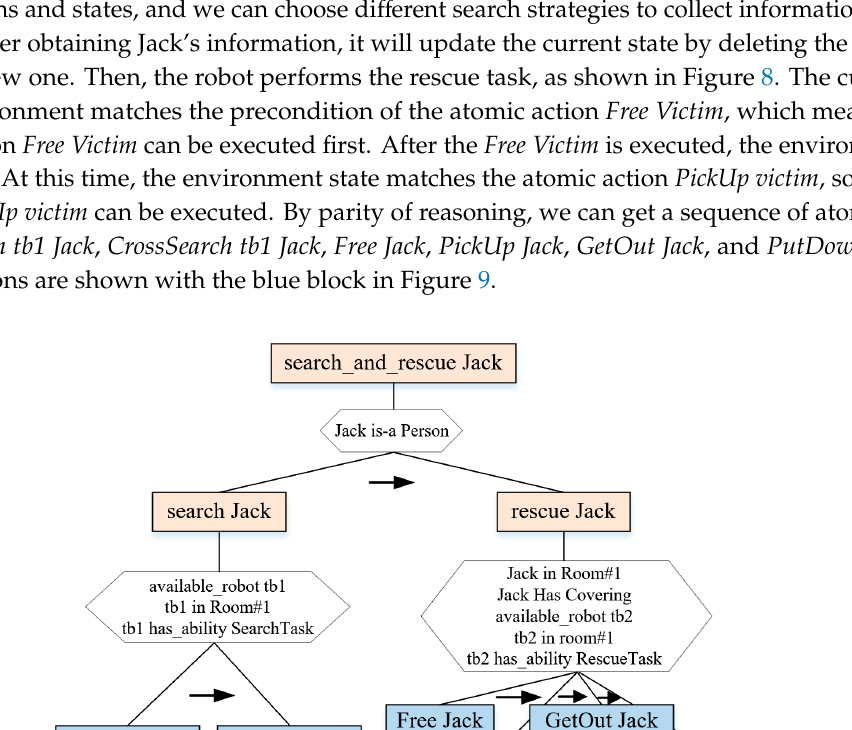
Algorithm 1 An ontology-based task planning algorithm